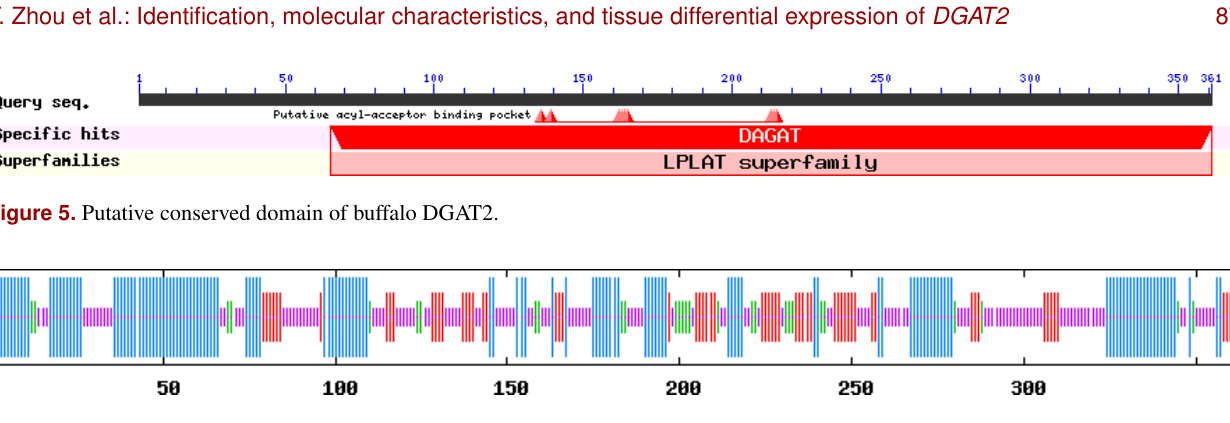
Figure 6. Predicted secondary structure of buffalo DGAT2. Alpha helices, extended strands, beta turns, and random coils are indicated with the longest, second longest, third longest, and shortest vertical lines, respectively.